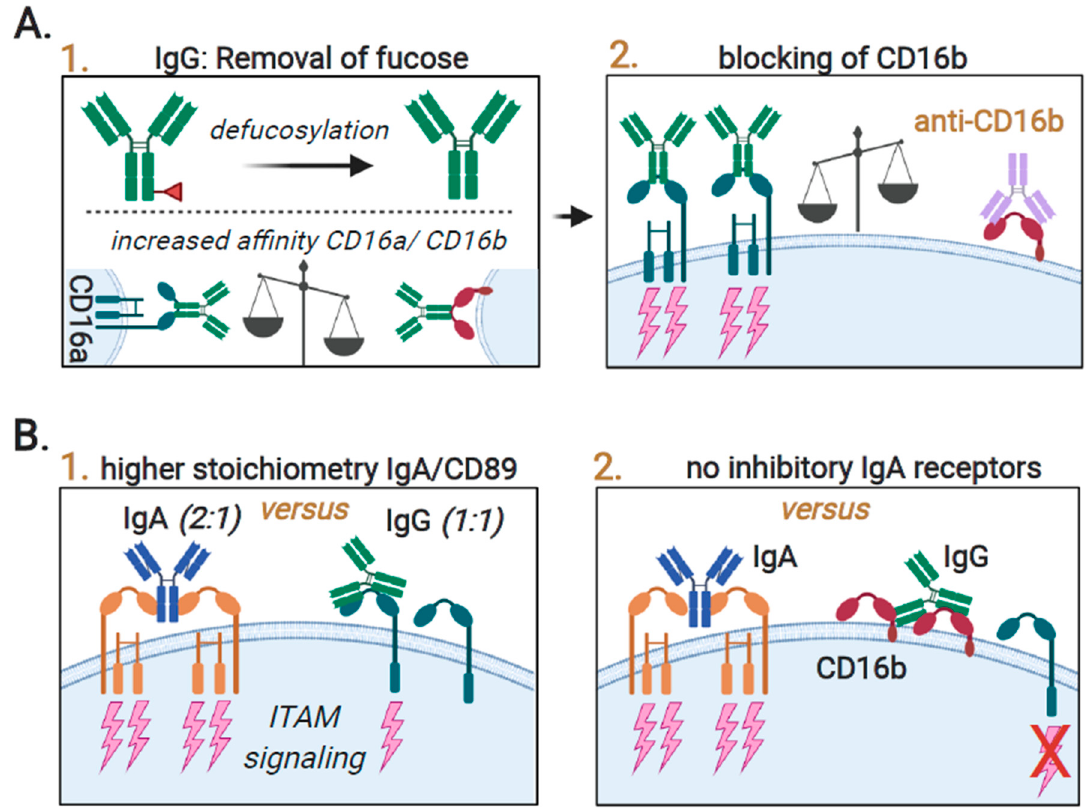
Figure 3. IgG versus IgA. ( A ) panel 1. The removal of fucose groups from antibodies (defucosylation / afucosylation) increases a ffi nity for Fc γ Rs and hence increases the activation of natural killer (NK) cells. However, neutrophils also express the inhibitory Fc γ R CD16b that is stronger bound by defucosylated antibodies as well, shifting the balance toward inhibitory signaling. ( A ) panel 2. CD16b-blocking antibodies prevent the interaction of therapeutic defucosylated antibodies to CD16b, shifting the balance toward activation. ( B ) panel 1. IgA binds with a higher affinity and stoichiometry to CD89 than IgG to CD32a. Specifically, IgA binds in a bivalent (2:1) conformation to CD89, resulting in the activation of four immunereceptor tyrosine-based activation motifs (ITAMs). In contrast, IgG binds in a monovalent (1:1) conformation to CD32a, yielding only one active ITAM motif. ( B ) panel 2. Whereas neutrophils express very high levels of CD16b, a non-signaling decoy inhibitory receptor for IgG, they do not express inhibitory FcRs for IgA.